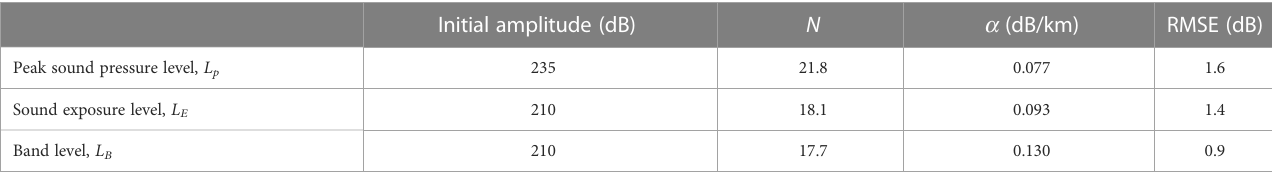
TABLE 2 Initial amplitude of regression curves for L p , L E and L B which mean SPL calculated from the near- fi eld hydrophone